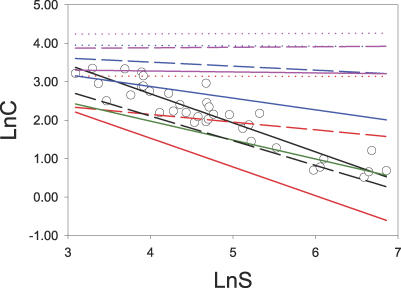
Connectivity of Networks of Increasing Size (S) for Real-World and Modelled Data MatricesCircles indicate real-world data (N = 37), the continuous black line indicates an empirical fit to real-world data, and the broken black line is the result of lognormal-neutral models. Colour lines indicate the fits to modelled data sets: narrow-range complementarity models are red, broad-range complementarity models are magenta, barrier models are blue, and mixed models are green. Dotted lines indicate one-trait models, broken lines indicate two-trait models, and continuous lines indicate four-trait models.